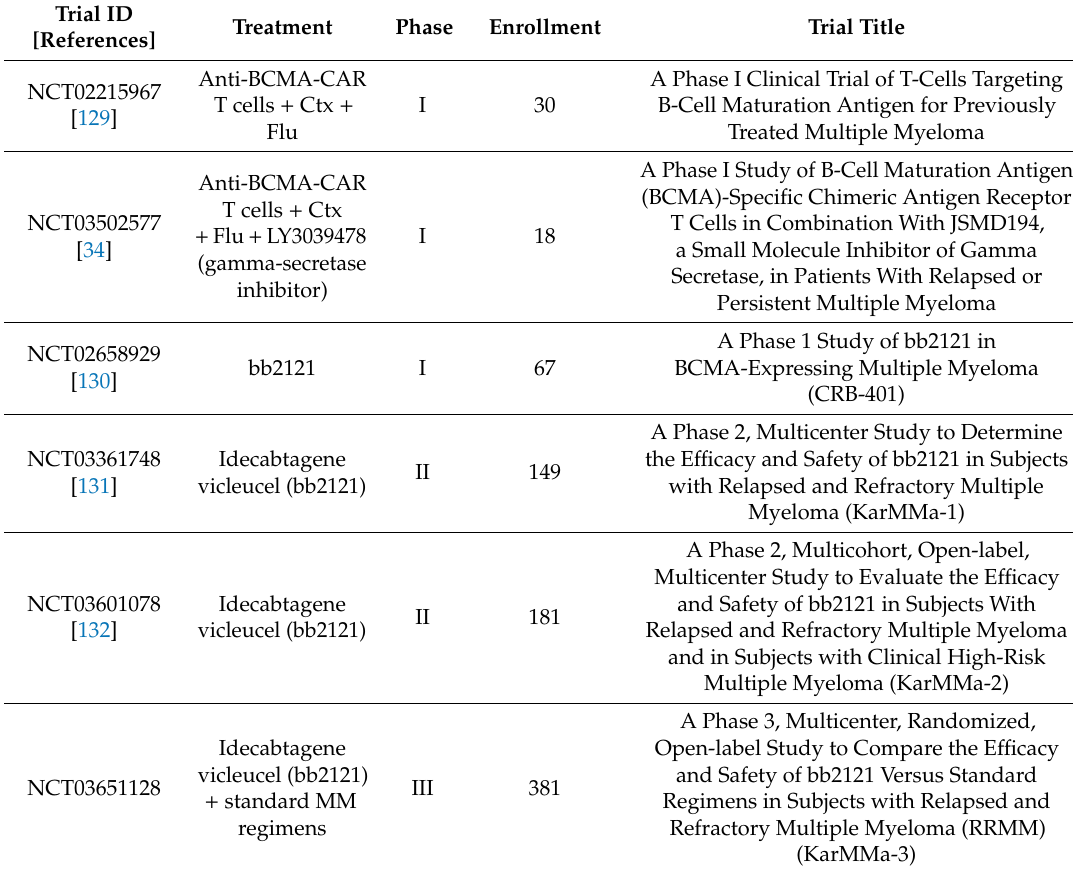
Table 3. Active trials of BCMA-targeted chimeric antigen receptor T-Cells in RRMM. Trial